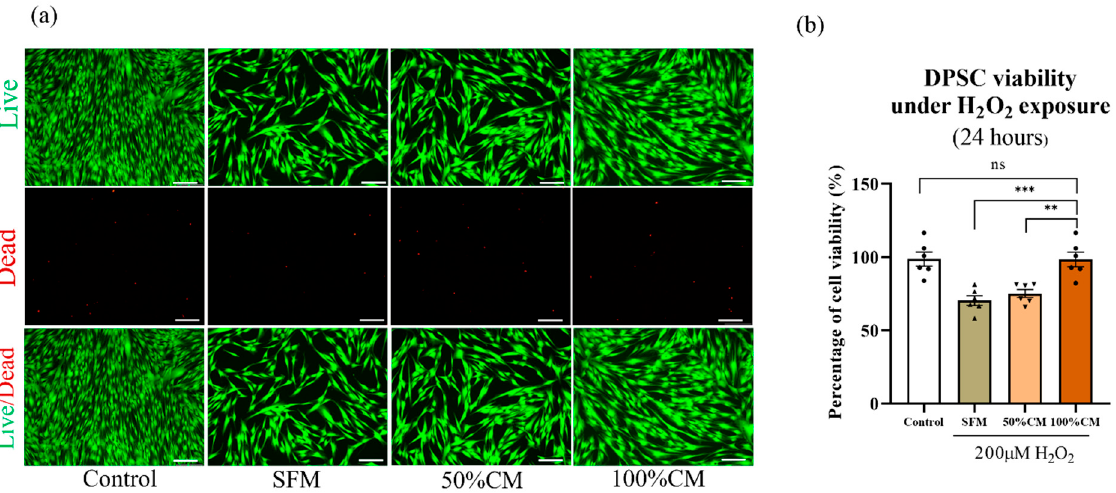
Figure 3. Treatment with SHED CM improved the viability of DPSC after H 2 O 2 exposure. DPSCs were cultured with 200 µ M H 2 O 2 for 12 h before shifting to 100% CM, 50% CM and SFM for another 12 h. ( a ) Representative live and dead images of DPSCs confirmed the antioxidative stress effect of SHED-CM. ( b ) Cell viability was determined by CCK-8 analysis. All data are represented as the mean ± SD. The statistical significance was calculated using one-way analysis of variance (ANOVA) to compare groups. Represents ** p < 0.01, **** p < 0.001, ns = not significant, scale bar = 200 μ m.